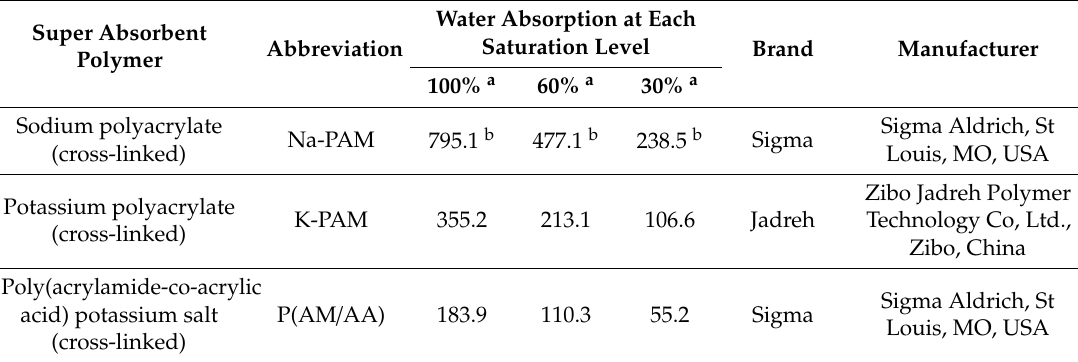
Table 1. Basic information of each super absorbent polymer (SAP) used in the present study. Super